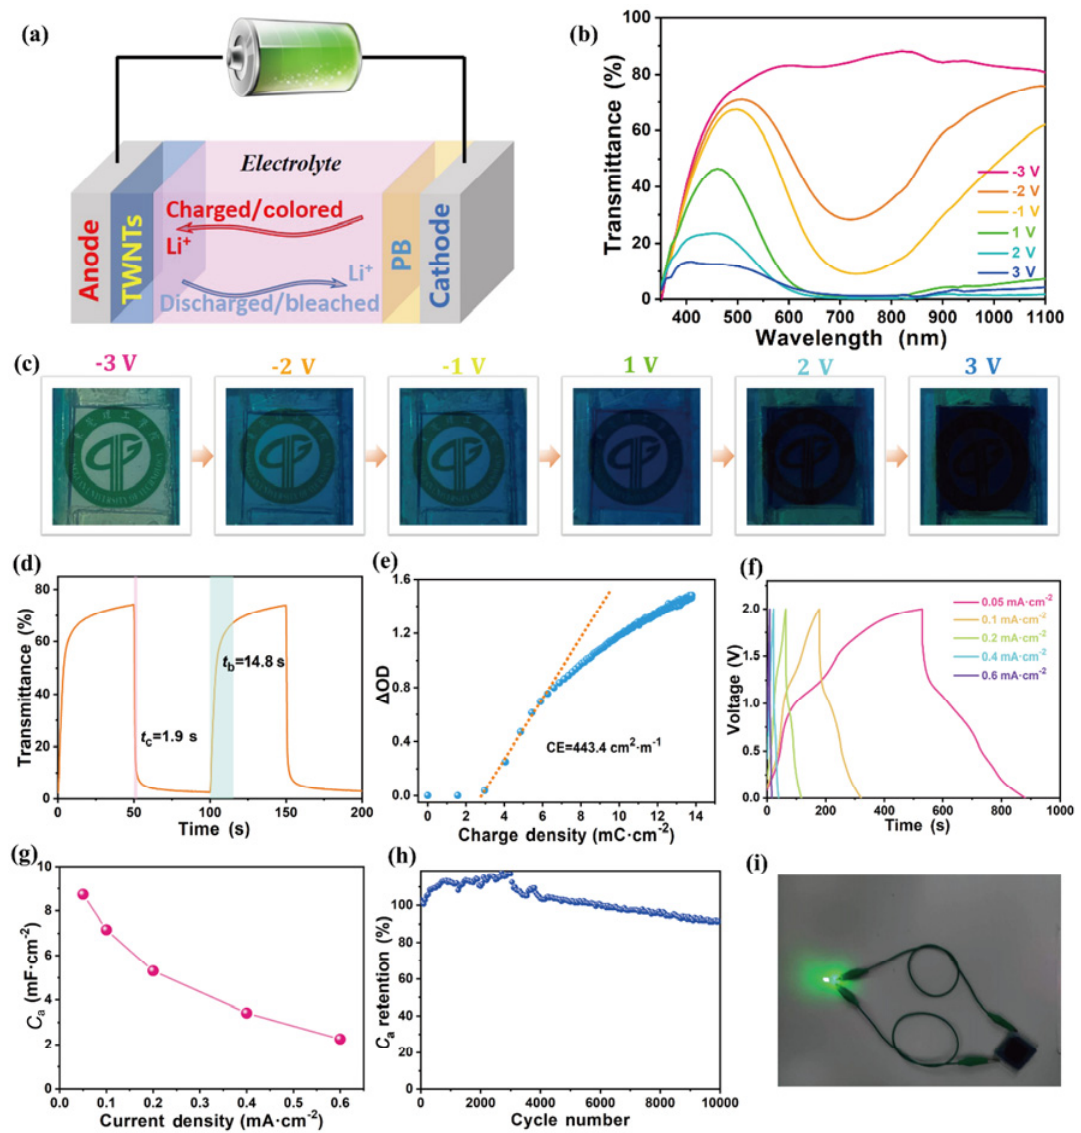
Fig. 7 Electrochromic and energy storage performance of the assembled EESD. Schematic illustration of the EESD (a), transmittance spectra (b) and corresponding digital photos under various voltages (c), time-dependent transmittance spectra at 633 nm (d), CE value (e), GCD curves (f), and C a values (g), cycle capacitive stability at a current density of 0.4 mA·cm − 2 (h), and the EESD to light up an LED bulb